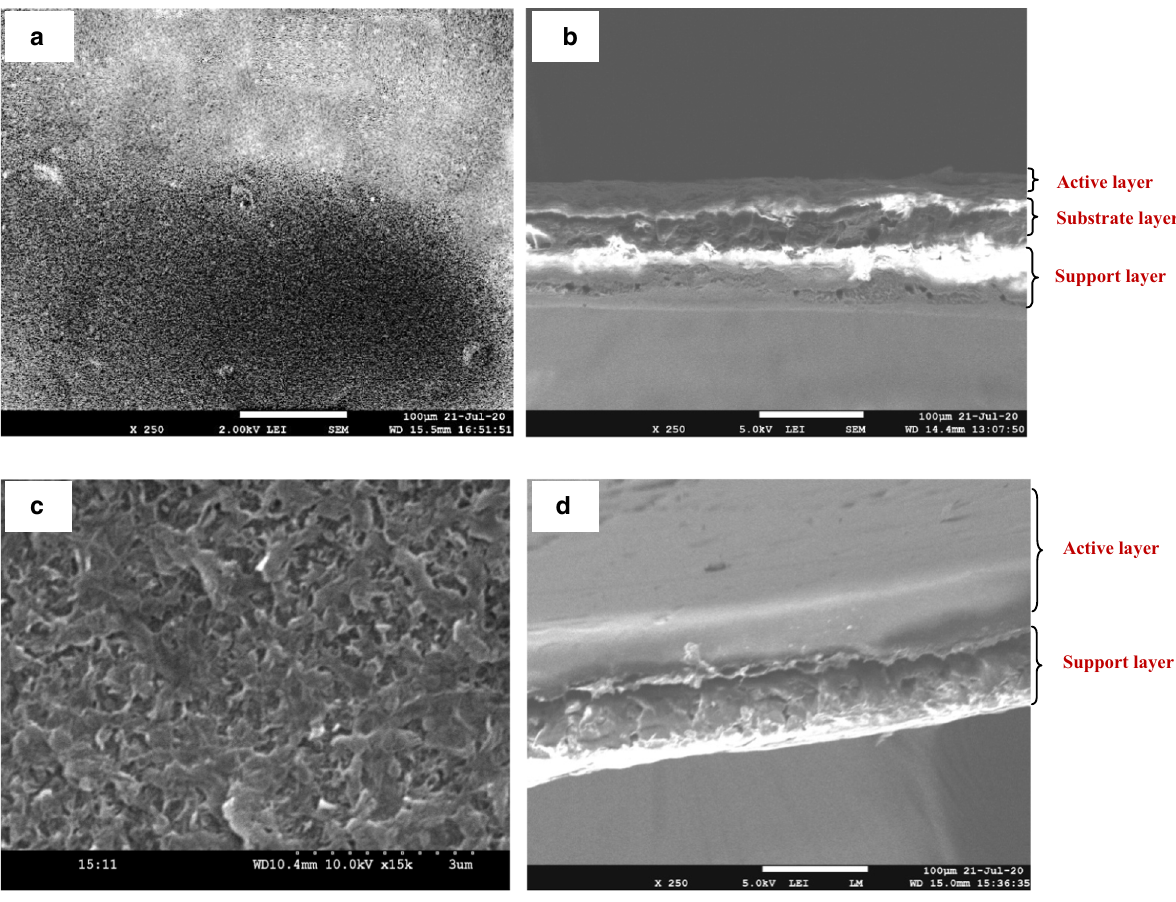
Fig. 7 SEM images of a surface and b cross section of pristine RO membrane, c surface and d cross section of hypo-treated RO membrane